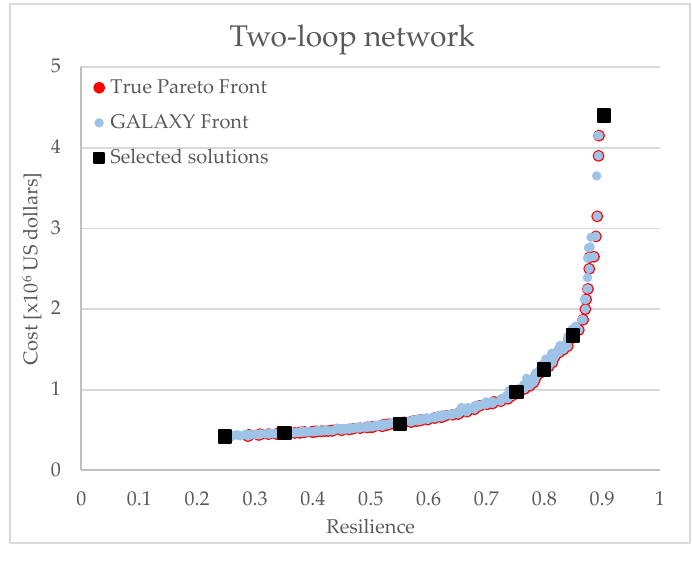
Figure 3. Pareto fronts of the TLN.